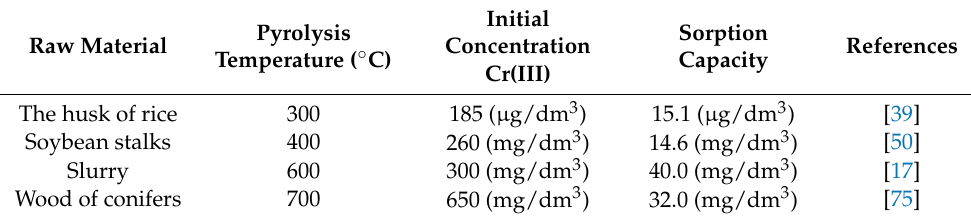
Table 5. The sorption capacity of biochars obtained from various raw materials and the pyrolysis temperature of their